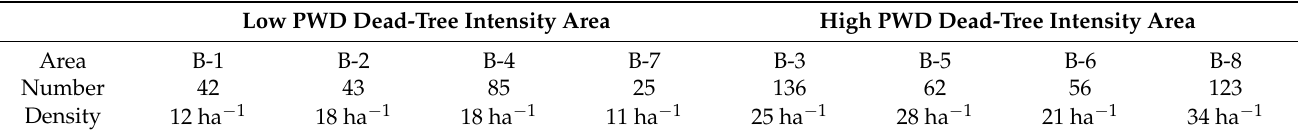
Table 2. Statistical information of standing dead trees in site